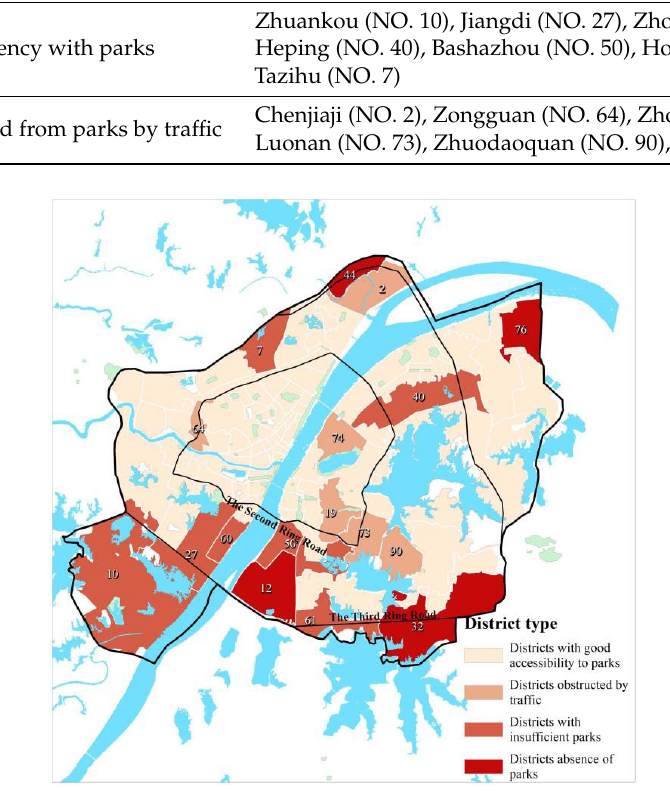
Figure 6. Typical district classification.